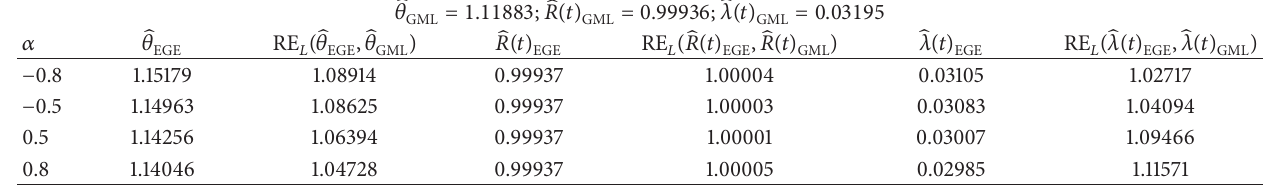
Table 8: The estimates and risk efficiencies for the progressive Type II censored data.